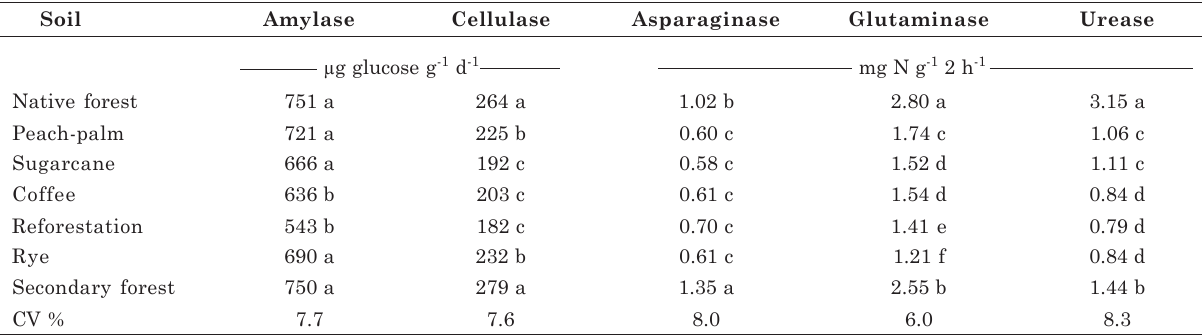
Table 3. Activity of enzymes related to C and N cycling in a clay soil under different types of management and plant